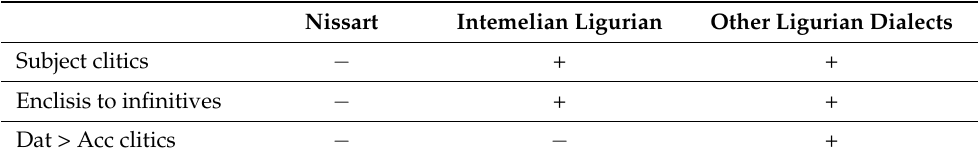
Table 1. Syntactic differences between eastern Occitan and western Ligurian dialects. The symbols + and − signal the presence vs. absence of the properties listed in the first column.